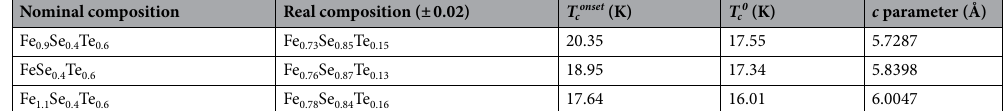
Table 2. The composition, onset and zero-resistivity temperature, and c -axis lattice parameter of thin films for nominal composition Fe y Se 0.4 Te 0.6